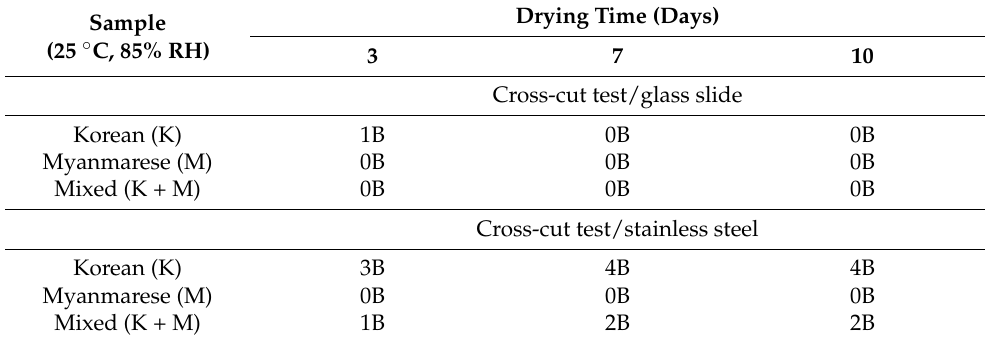
Table 4. Cross-cut test of Oriental lacquer films on a glass slide and a stainless-steel plate.